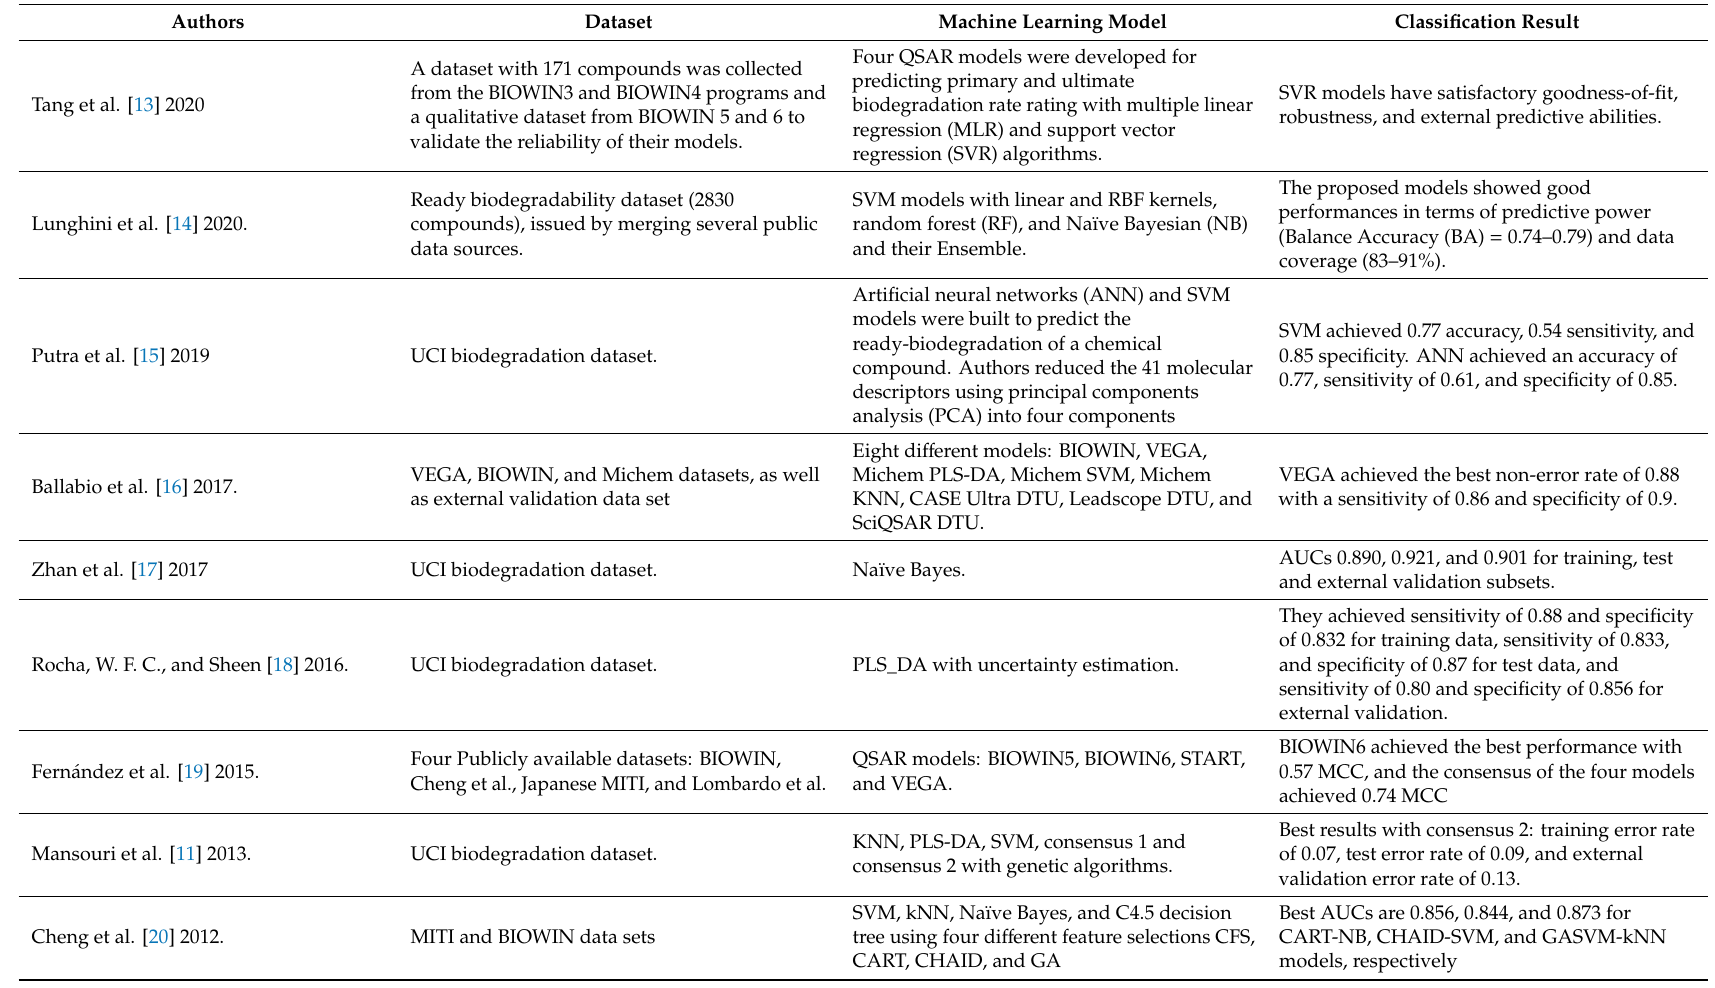
Table 1. Related work on the classification of biodegradable